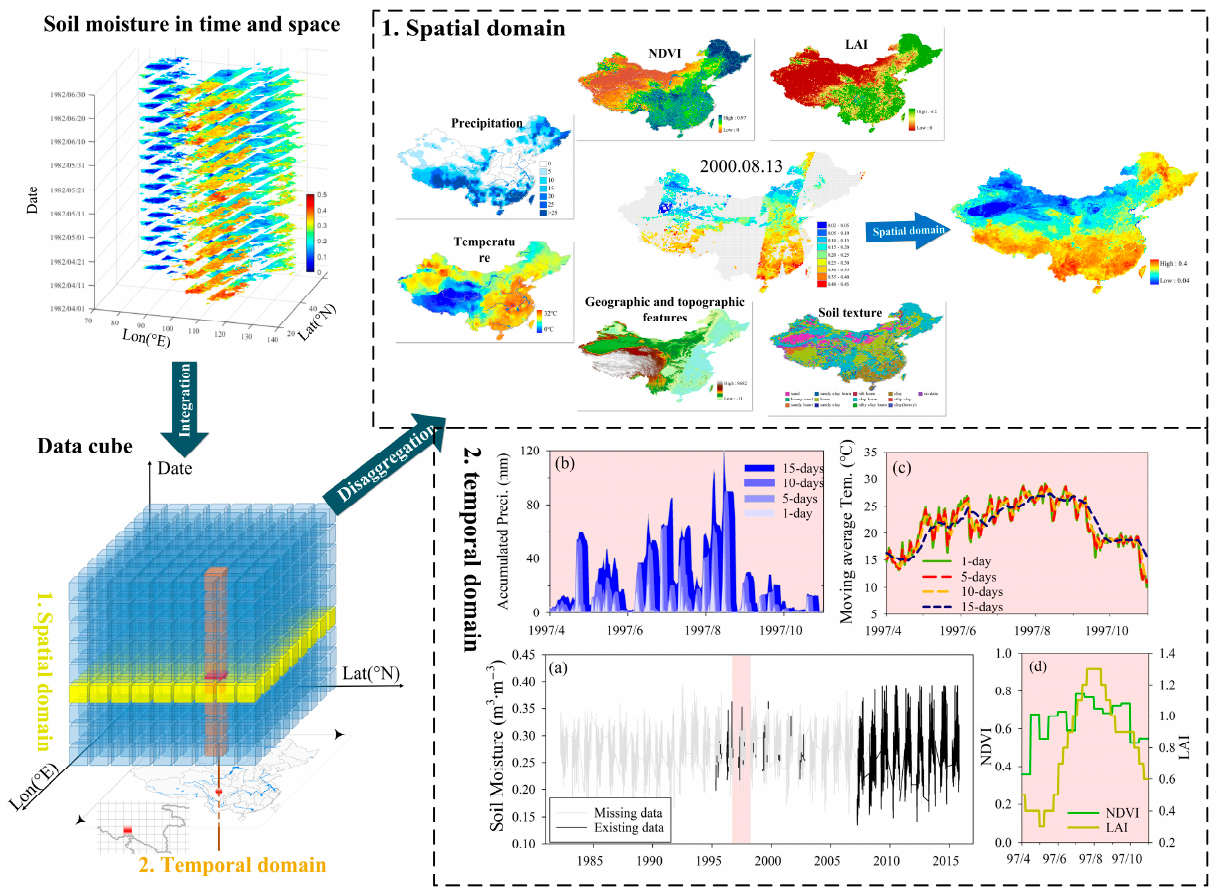
Figure 3. A sketch map of reconstructing soil moisture in the temporal and spatial domains. ( a ) Soil moisture in the temporal domain. ( b ) Accumulated precipitation in the temporal domain. ( c ) Moving average temperature in the temporal domain. ( d ) NDVI and LAI in the temporal domain.